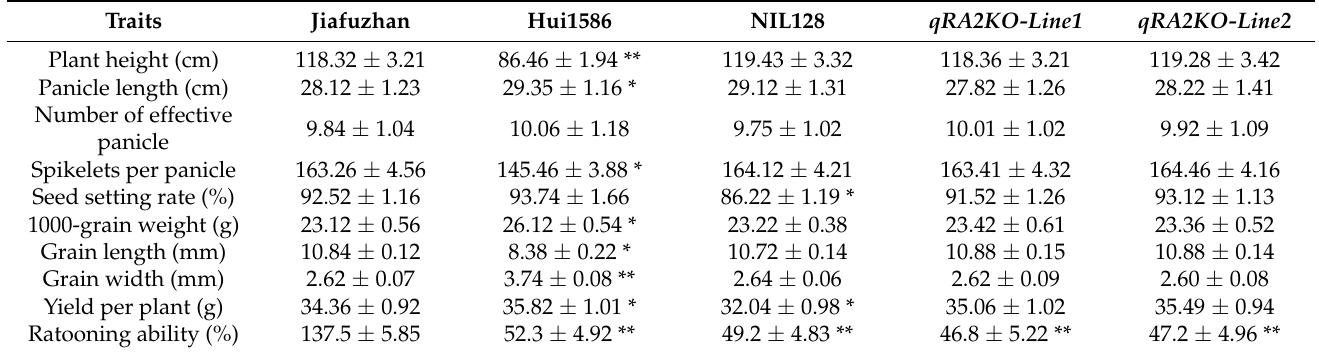
* and ** indicate the significance levels of the differences between Jiafuzhan, NIL128 and knockout lines at p < 0.05 and p < 0.01, respectively. The data was derived from the trial that was performed at the Fuzhou experimental station in June Table 1. Comparison of the main agronomical traits of Jiafuzhan, NIL128, and the qRA2KO knock- out mutant lines.